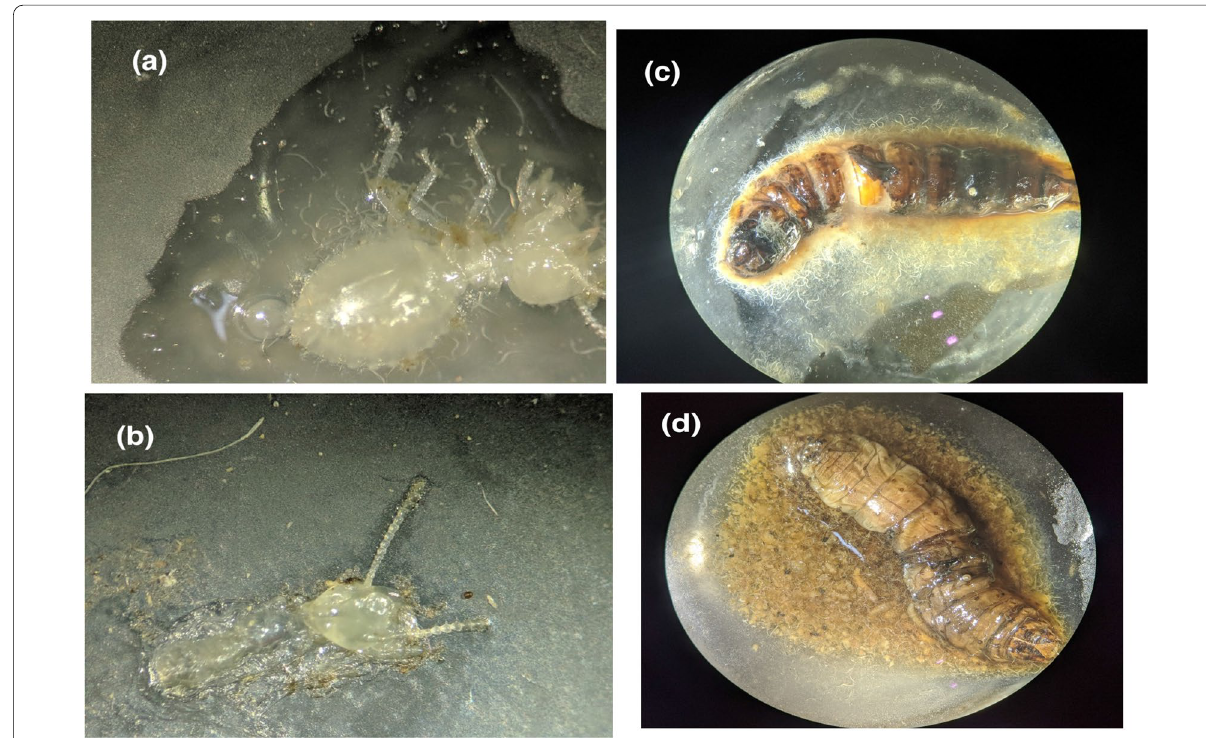
Fig. 5 Emergence of EPNs from cadaver , a from O. obesus worker due to H. bacteriophora infection, b from O. obesus worker due to S. aciari infection, c from A. ipsilon larva due to H. bacteriophora infection, and d from A.ipsilon larvae due to S. aciari